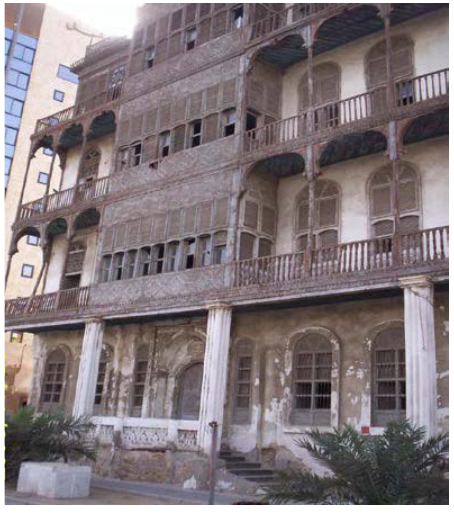
Fig 3. Rawsheen in Sharbatly building